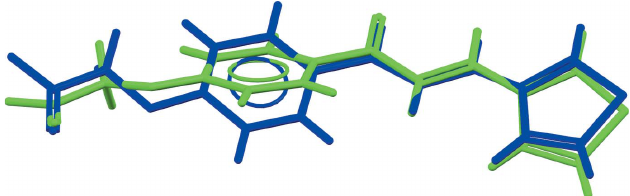
Figure 3 Octahedral coordination around K in the title compound [symmetry codes: (i) x + 1, y , z , (ii) (cid:4) x + 2, (cid:4) y + 2, (cid:4) z + 1, (iv) (cid:4) x + 1, (cid:4) y + 1, (cid:4) z + 1].